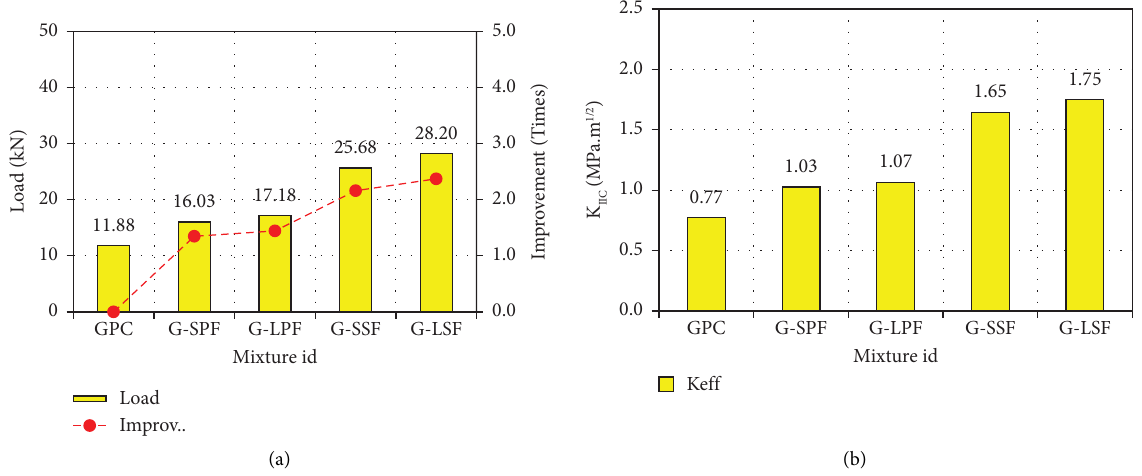
Figure 14: Mixed-mode fracture toughness of specimens under 75 ° loading.